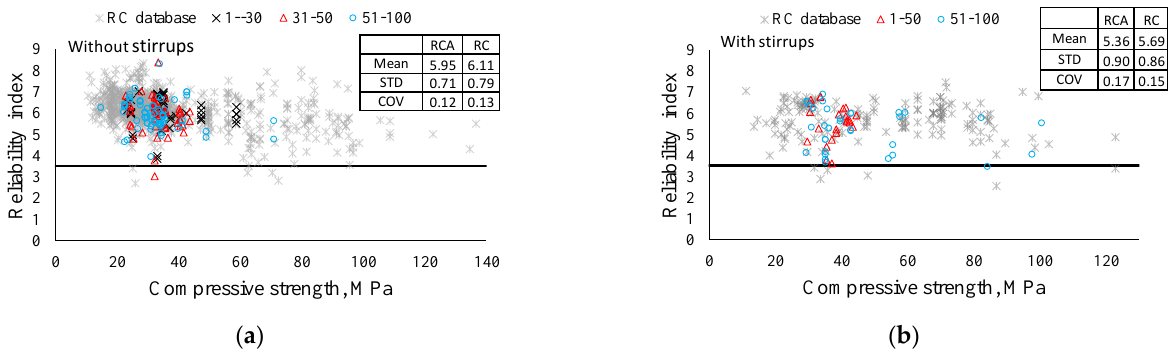
Figure 9. Verification of RCA beam results with RC beam database. ( a ) Specimens without shear reinforcement. ( b ) Spec- imens with shear reinforcement.